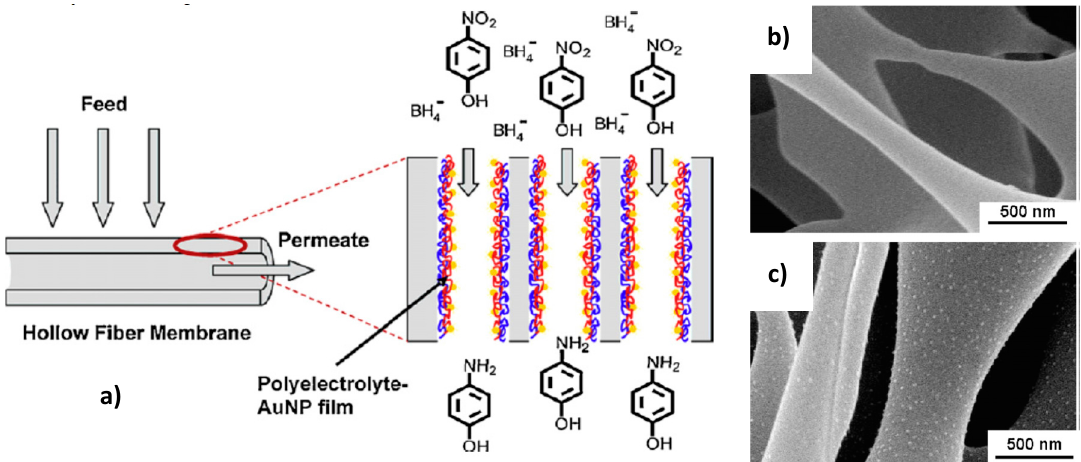
Figure 15. Modification of hollow fiber membrane using LbL technique ( a ) and SEM images of pristine PS ( b ) and coated ( c ) with a poly(styrene sulfonate) / poly(allylamine hydrochloride) / gold nanoparticles (PSS / PAH / AuNPs) samples. (Reprinted from [60]).